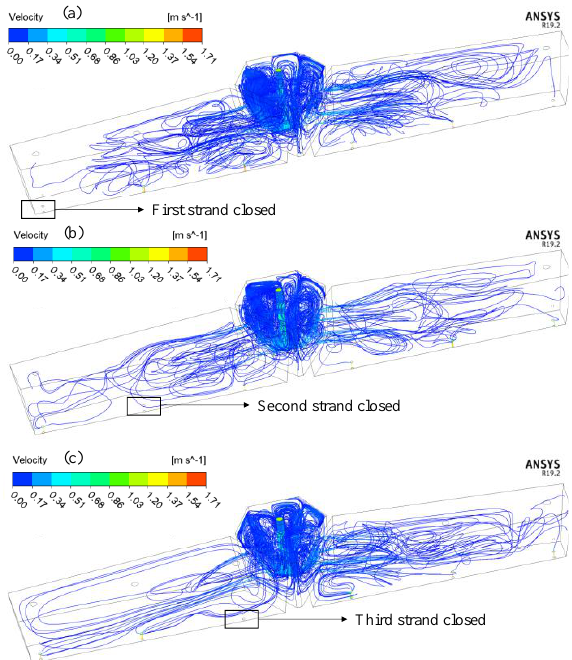
Figure 6. Liquid steel flow diagram in tundish for fewer strands casting: scheme 1 ( a ); scheme 2 ( b ); scheme 3 ( c ).